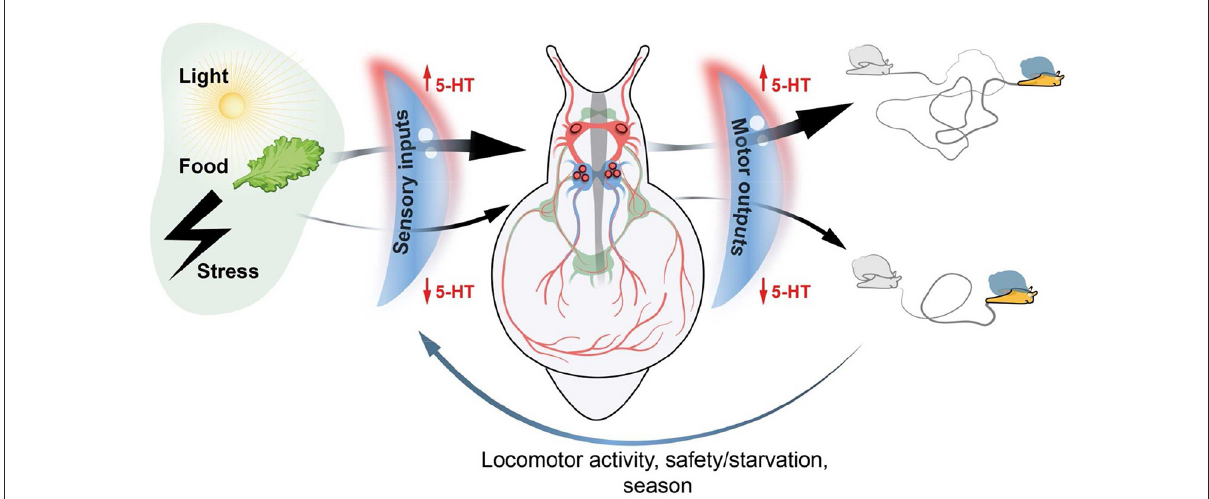
FIGURE1 Schematic representation of integrative serotonin action. Serotonin (5-HT) acts as a volume transmission signal tuning both sensory inputs and motor outputs in the nervous system of mollusks. 5-HT has a gating modulatory function for external stimuli of various modalities by amplifying or attenuating the signal generated by sensory neurons. 5-HT also acts as a gating mediator required for certain activities of the central neural circuits (Central Pattern Generators) which generate high or low motor output and the corresponding activity of the animal. A complex of internal and external factors (locomotor activity, satiety/starvation state, and season) in turn influences 5-HT level within the nervous system and in the peripheral local networks. Thus, the serotonin level in local area surrounding certain peripheral and central neurons orchestrates the complex behavior of the animal and enables the organism to adapt current